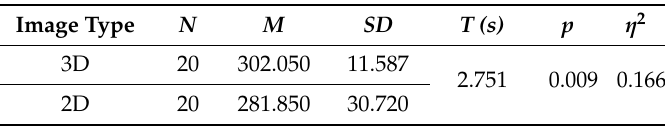
Table 5. Test of